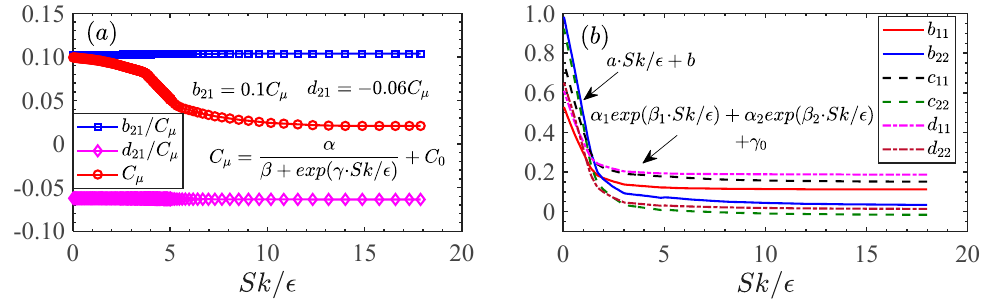
Figure 3. Closure coe ffi cients as a function of dimensionless shear parameter Sk / (cid:15) in fully-developed turbulent channel flow: ( a ) coe ffi cients appearing in the Reynolds shear stress C µ , b 21 and d 21 , and ( b ) coe ffi cients appearing in the normal Reynolds stress b 11 , b 22 , c 11 , c 22 , d 11 and d 22 . The wall distance reduces with increasing Sk / (cid:15) when Sk / (cid:15) <